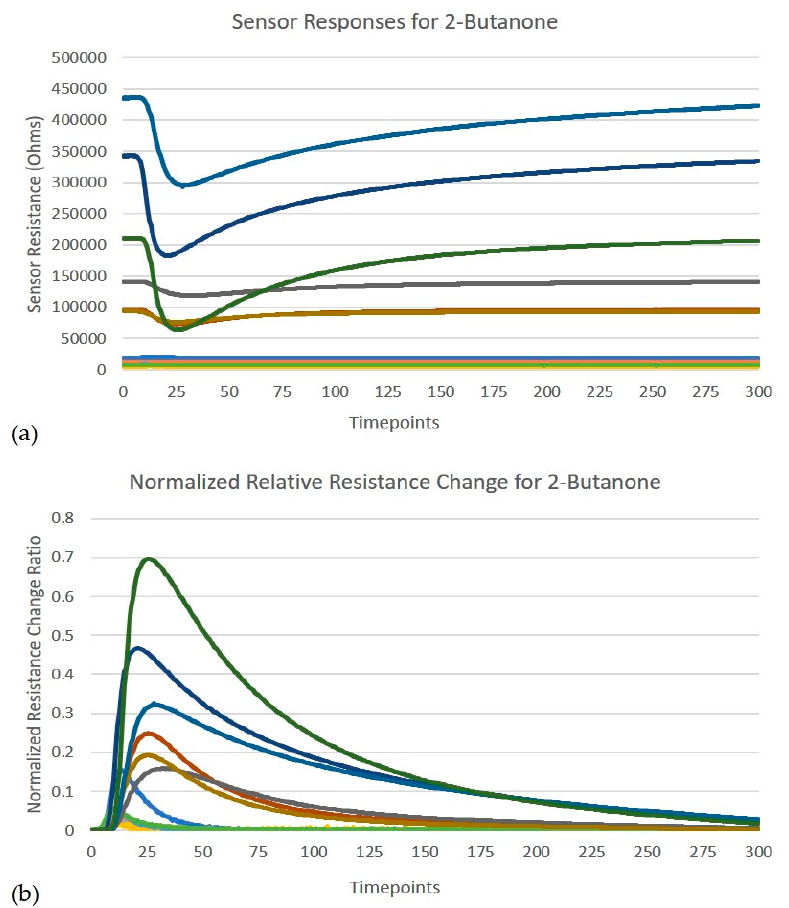
Figure 2. Feature extraction based on relative resistance change. ( a ) Represents the raw timeseries response of the 12-sensor array for 2-butanone ( b ) Shows normalized relative resistance curves after feature extraction for the same sample.